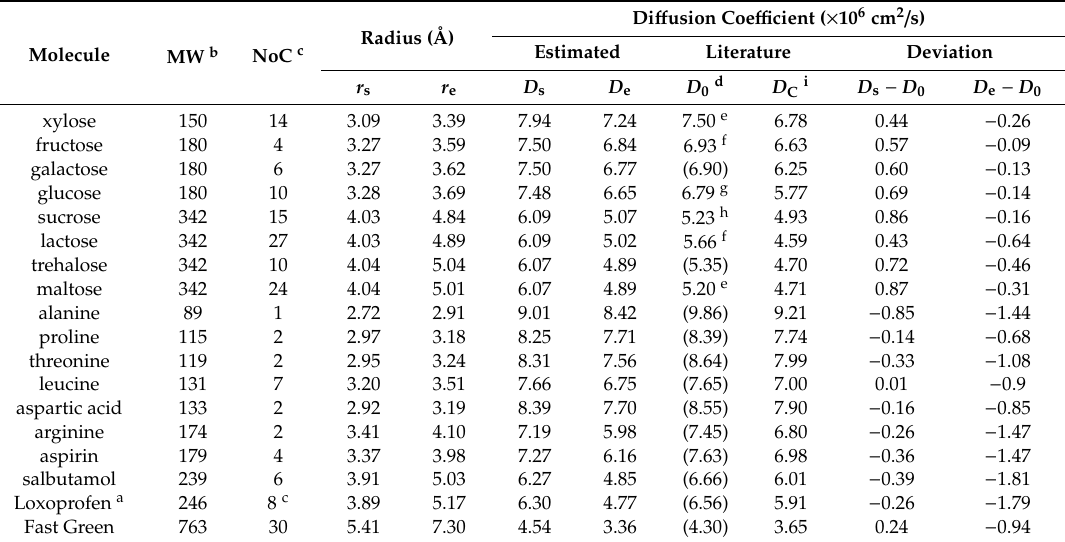
Table 1. Approximated radii and di ff usion coe ffi cients of small